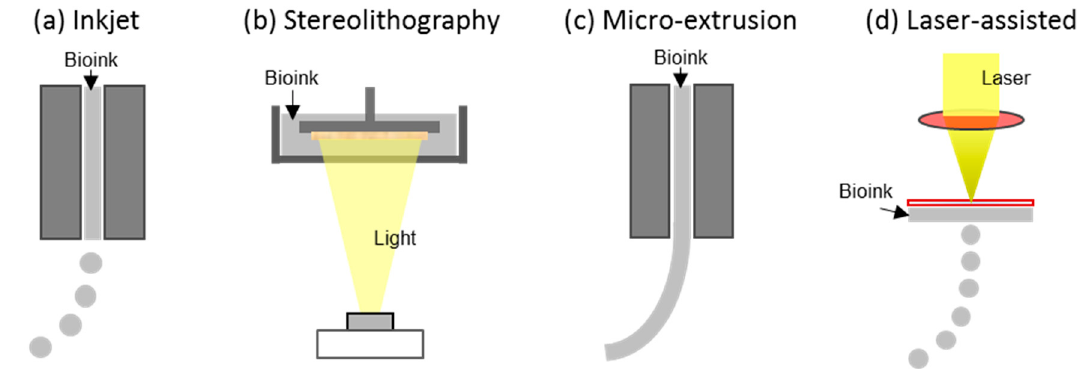
Figure 4. Schematic diagram of four common bioprinting systems.